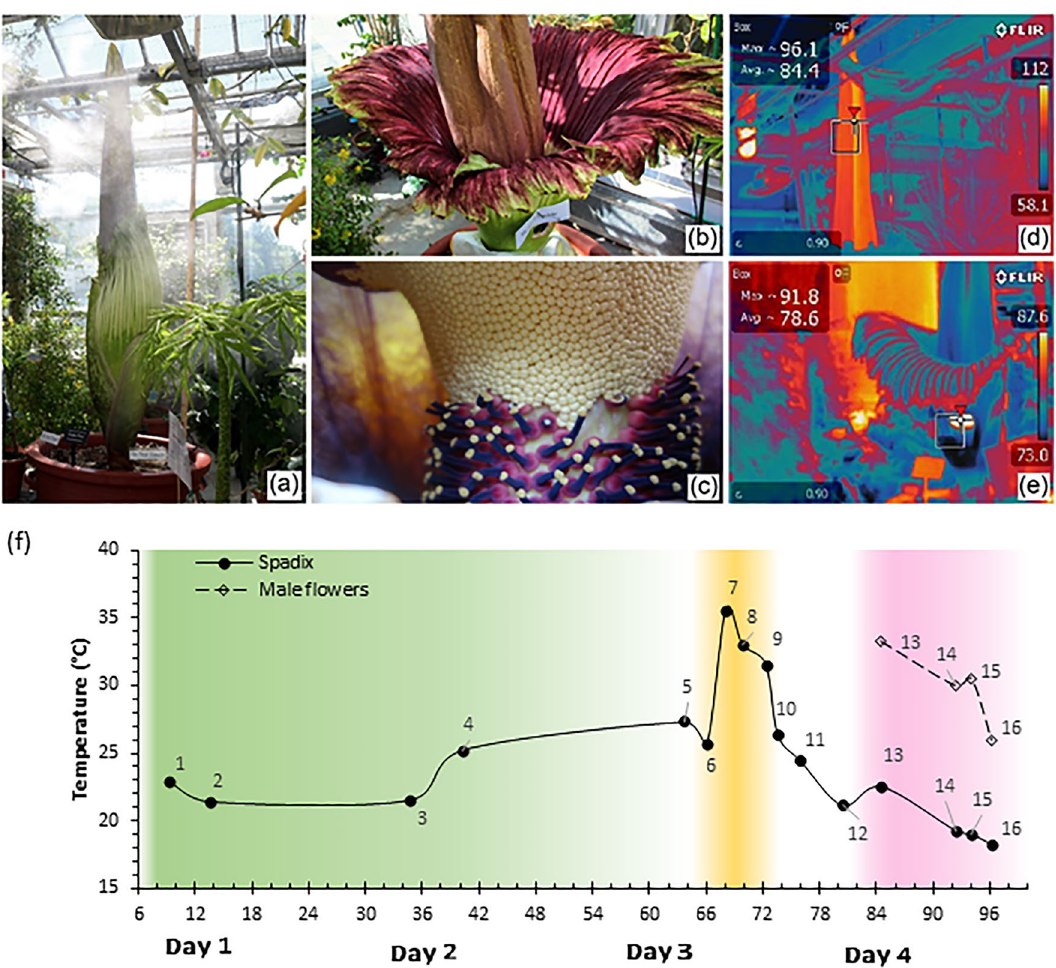
Figure 1. Temperature and odor changes during A. titanum flowering: Image of A. titanum ( a ) before flowering, ( b ) during flowering, and ( c ) male and female flowers; ( d ) thermal image of the spadix during the female flowering phase; ( e ) thermal image of the florets during the male flowering phase; ( f ) temperature profile of the spadix and the male flowers. The numbers 1–16 represent the samples collected at different time